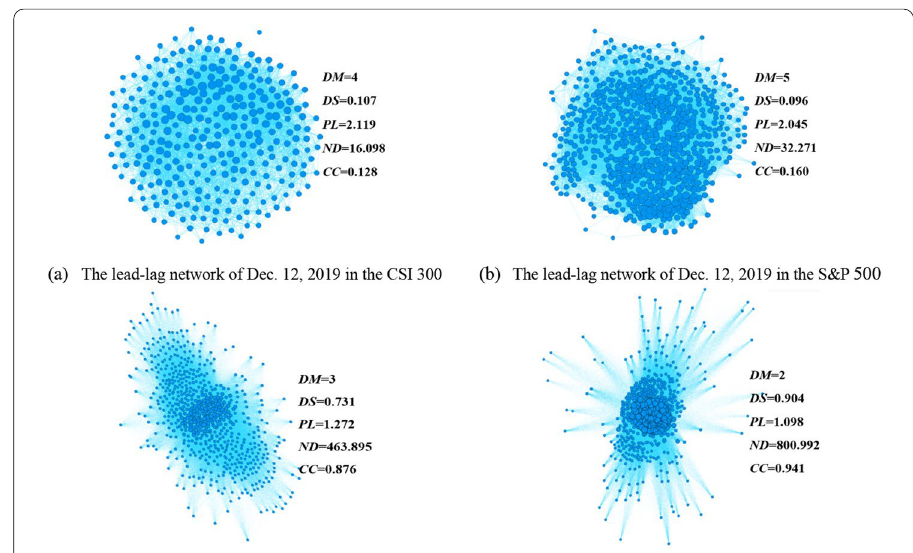
Fig. 4 The lead–lag networks achieved in the two selected stock sets (Δ